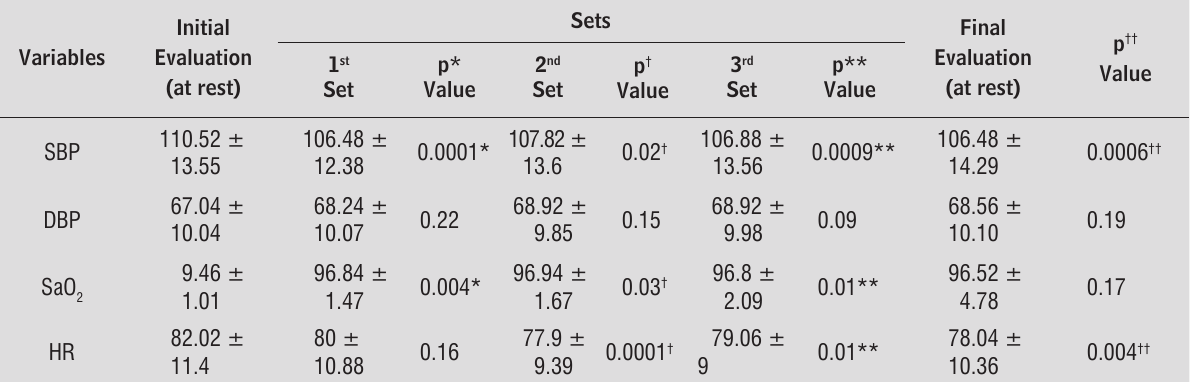
Table 2 - Comparison between the cardiorespiratory variables: initial, final, and during the execution of each of the three sets of fifteen repetitions – M3.